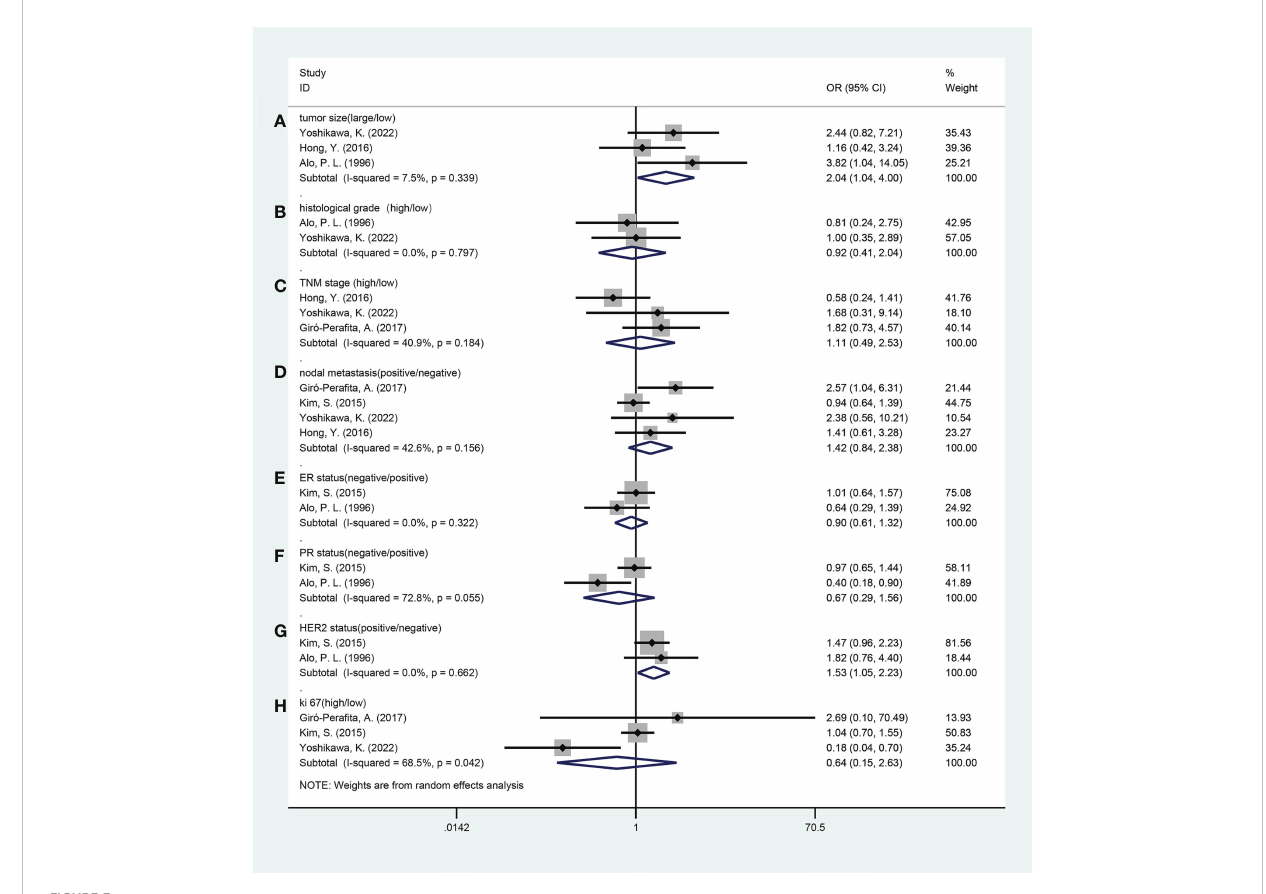
FIGURE 3 Forest plots of the relationship between fatty acid synthase expression level and clinicopathological features. (A) Tumor size (large vs. small); (B) Histological grade (high vs. low); (C) TNM stage (high vs. low); (D) Nodal metastasis (yes vs. no); (E) ER status (negative vs. positive); (F) PR status (negative vs. positive); (G) HER2 status (positive vs. negative); (H) Ki-67 (high vs. low). ER, estrogen receptor; PR, progesterone receptor; HER2, human epidermal growth factor receptor 2; OR, odds ratio; CI, con fi dence interval.